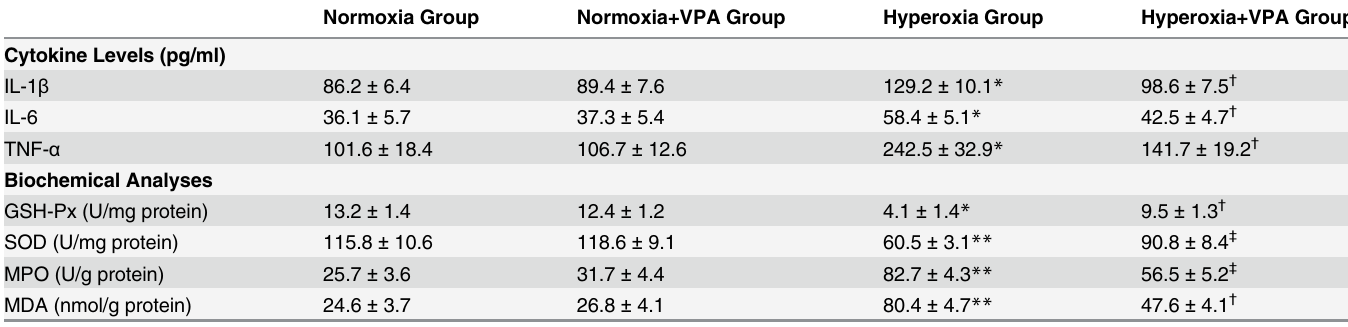
Table 1. Comparison of lung tissue pro-inflammatory cytokine levels and superoxide dismutase (SOD), glutathione peroxidase (GSH-Px) and mye- loperoxdase (MPO) activities and malonedialdehyde (MDA) content in all groups.